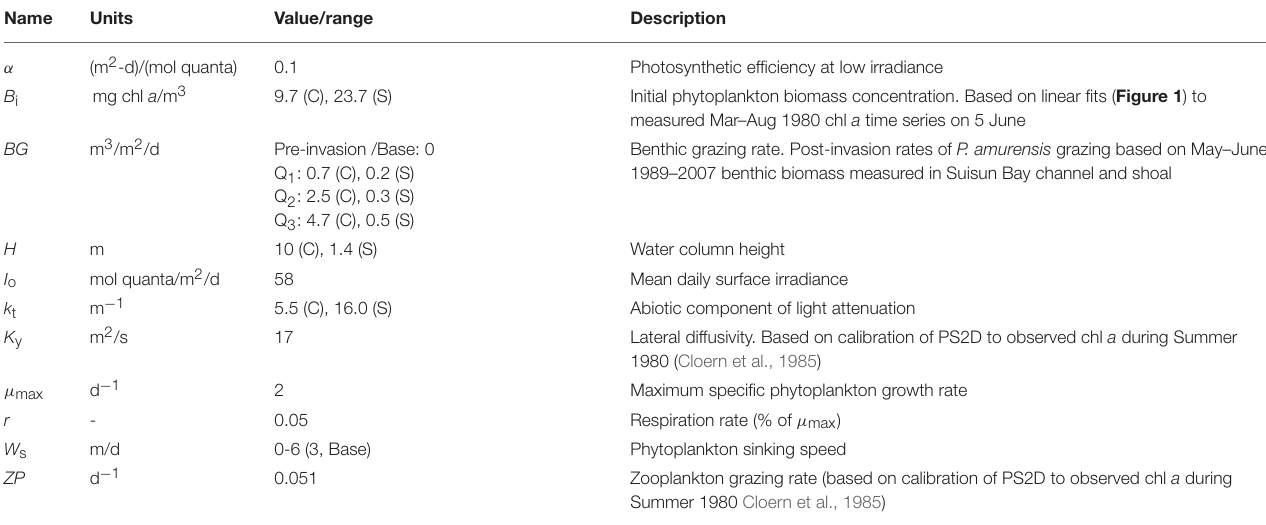
TABLE 2 | Model variables and constants used in PS2D simulations of coupled shoal-channel depiction of Suisun